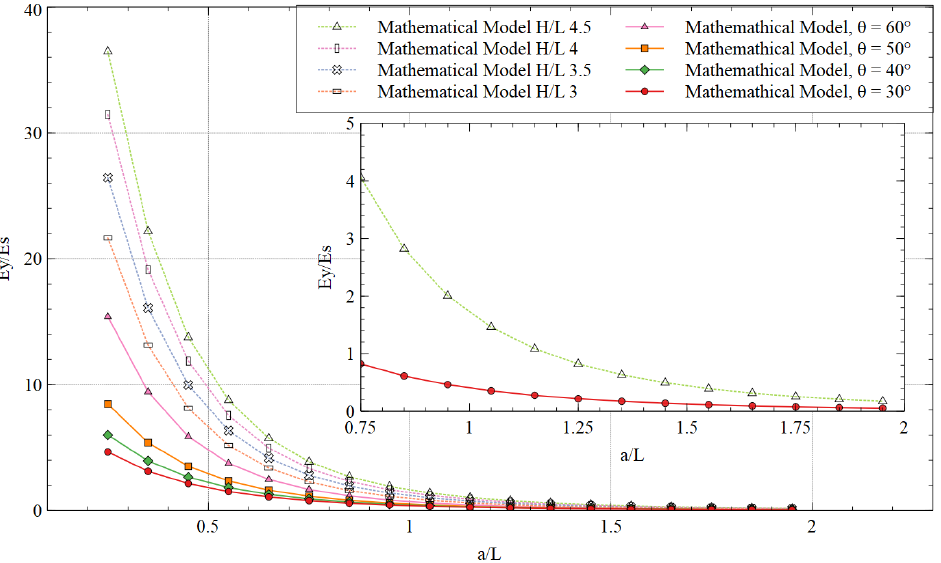
Figure 19. Young’s modulus in they-direction for different values of H/L and re-entrant angle (inset shows a portion of the extreme values).